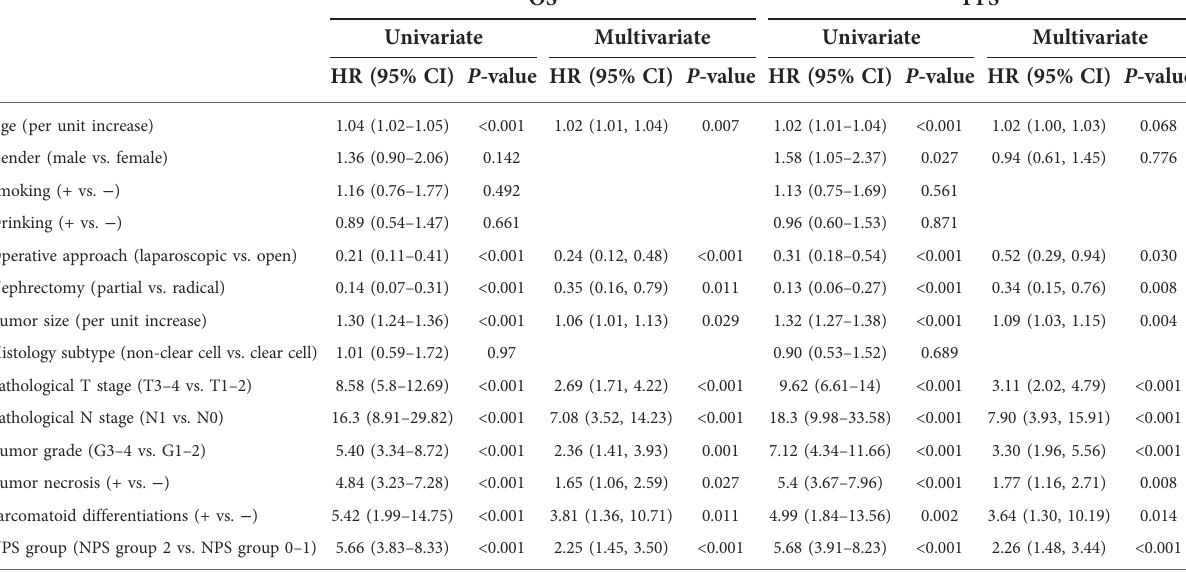
TABLE 2 Univariate and multivariate analysis of prognostic factors for OS and PFS in the patients with RCC ( n =638).